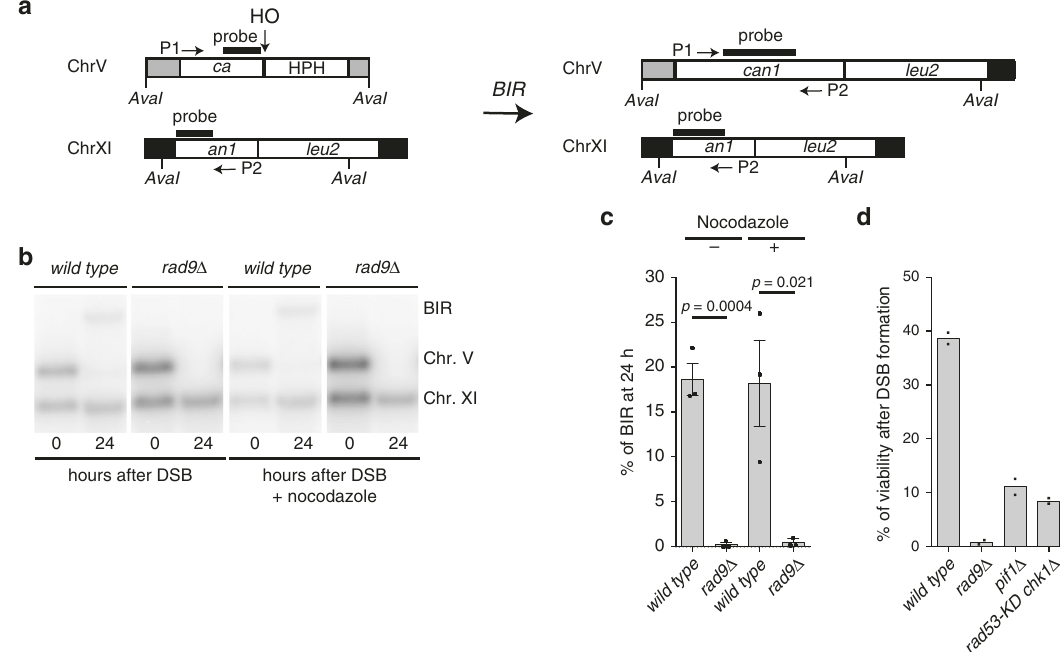
Fig. 2 Rad9 promotes DSB repair through BIR. a Scheme of the genetic system to test BIR in JRL092 background. b Southern blot of Ava I-digested DNA to monitor DSB repair through BIR in the indicated JRL092 strains. c Densitometric analysis of the BIR bands at 24 h of three experiments as in ( b ). Data represent mean ± SEM ( n = 3, biologically independent experiments). Statistical analysis was done using unpaired two-tailed Student ’ s t -test. d BIR ef fi ciency measured by cell viability in the indicated JRL092 strains ( n = 2, biologically independent experiments). See accompanying source data fi